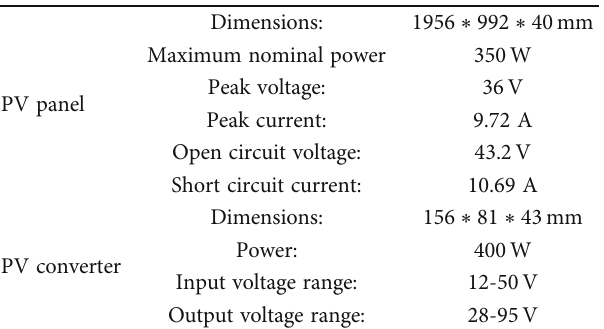
Table 2: Relevant parameters of photovoltaic (PV) panel and PV